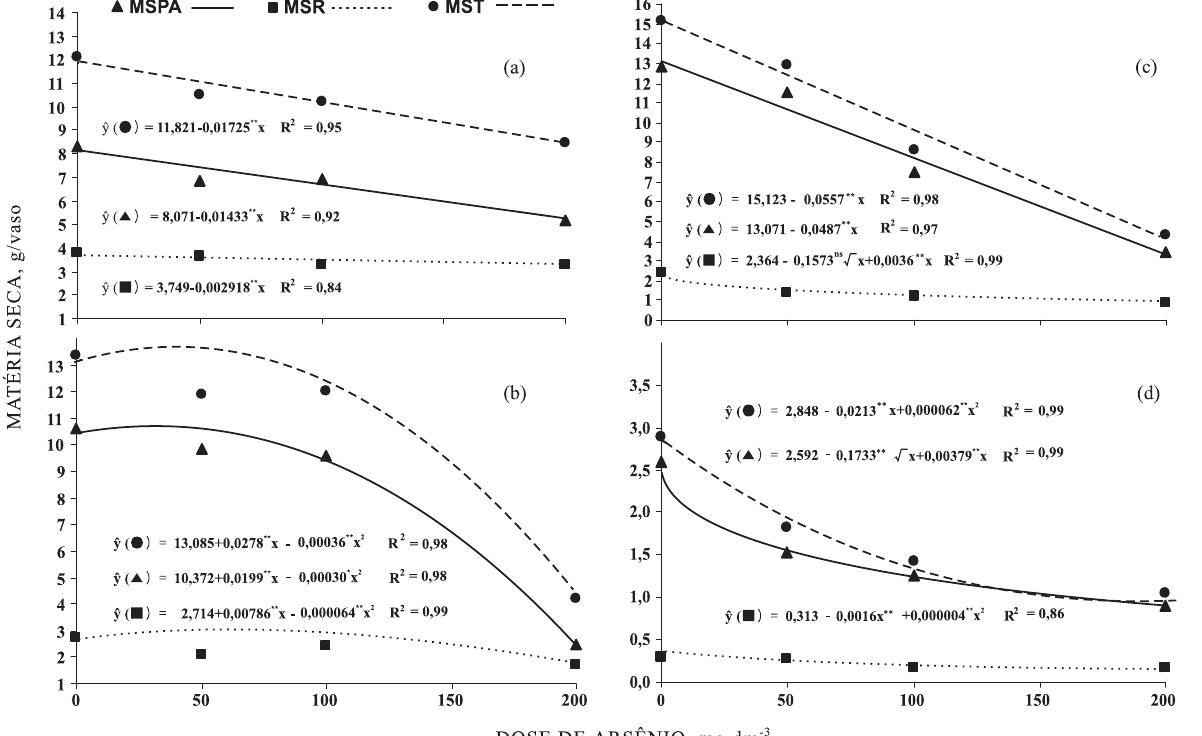
Figura 2. Matéria seca de raízes (MSR), parte aérea (MSPA) e total (MST) de aveia (a), azevém (b) amendoim (c), estilosante (d) submetidas a diferentes doses de As, cultivadas em amostras de um LVA de João Pinheiro-MG. **, * e ns : significativo de doses a 1 e 5 % e